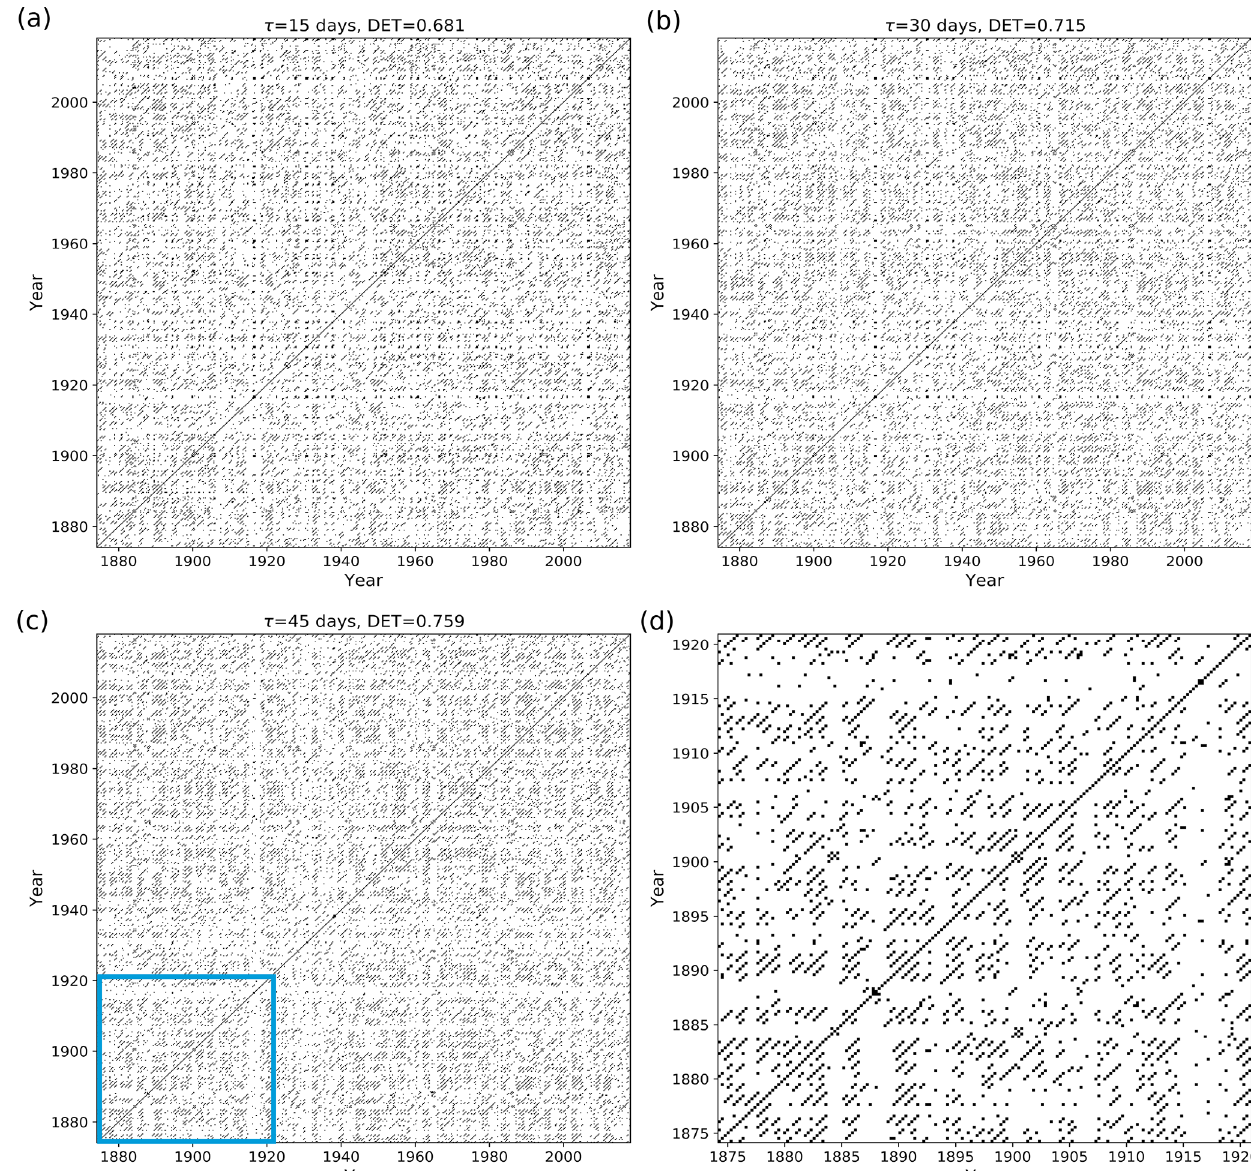
Figure 13. Recurrence plot of flood events using mED, window size = 1 year, with 9 months of overlapping for delays τ = (a) 15d, (b) 30d, and (c) 45d; (d) zoom-in image of the blue area of panel (c)